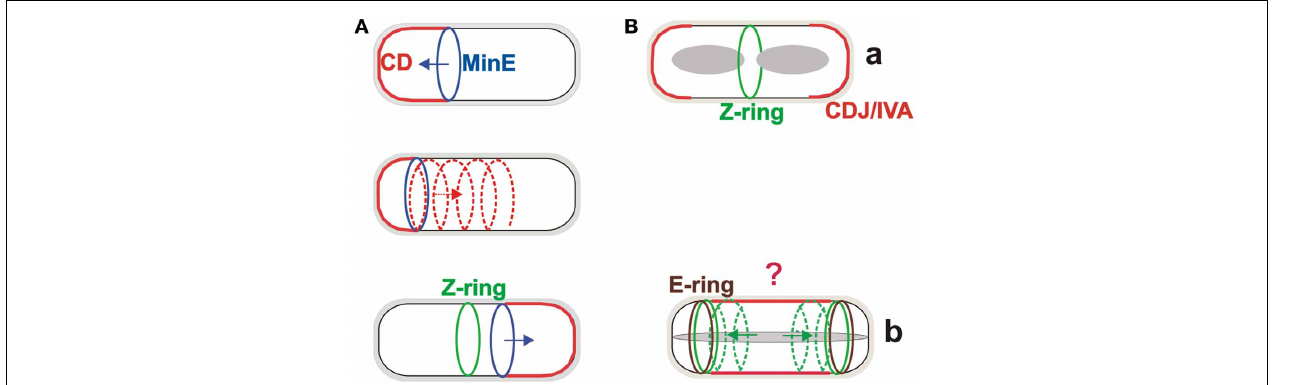
FIGURE 1 | The Min systems in division site selection in Escherichia coli and Bacillus subtilis . (A) The Min system in E. coli oscillates from one pole to the other on a helical trajectory, creating a concentration gradient of the MinC division inhibitor, with the lowest concentration at the mid-cell site where the Z-ring forms. (B) The MinCDJ/DivIVA complex (CDJ/IVA) during vegetative growth of B. subtilis is localized at the site of septation and cell poles (a) . During